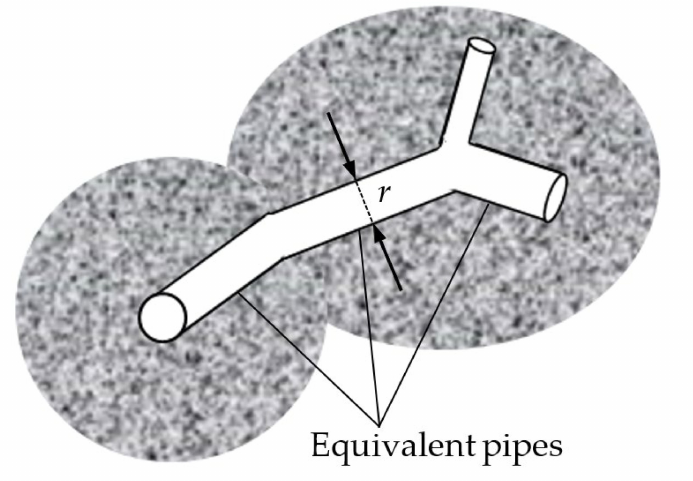
Figure 2. Schematic view of equivalent pipes of rock